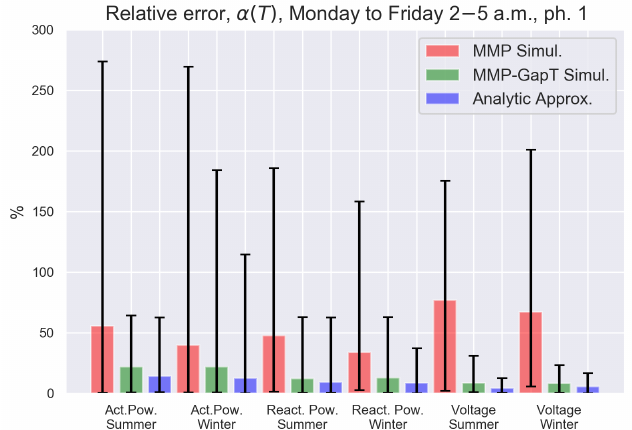
Figure 6. Comparison of relative deviation R i of Additive Alignment Error α ( T ) obtained from simulations of two models and from matrix analytic calculation of the MMP-GapT model relative to that from morning traces. Bars show the average for trace groupings, marked interval shows min and max of relative deviation of slopes.